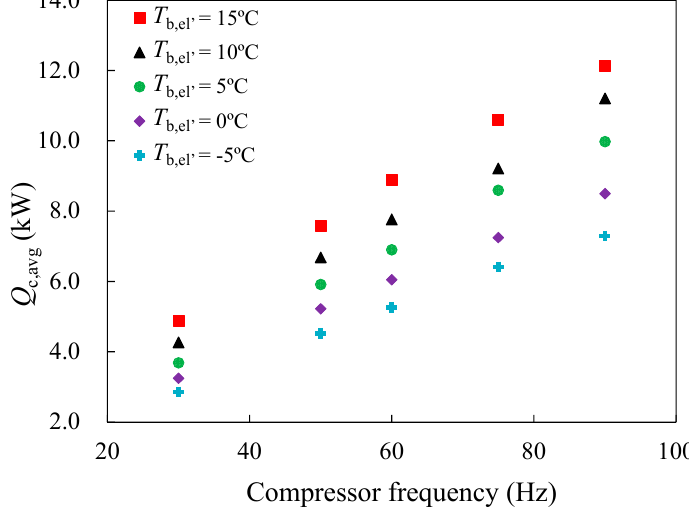
Figure 7. The heating capacity Q c,avg as a function of compressor frequency.